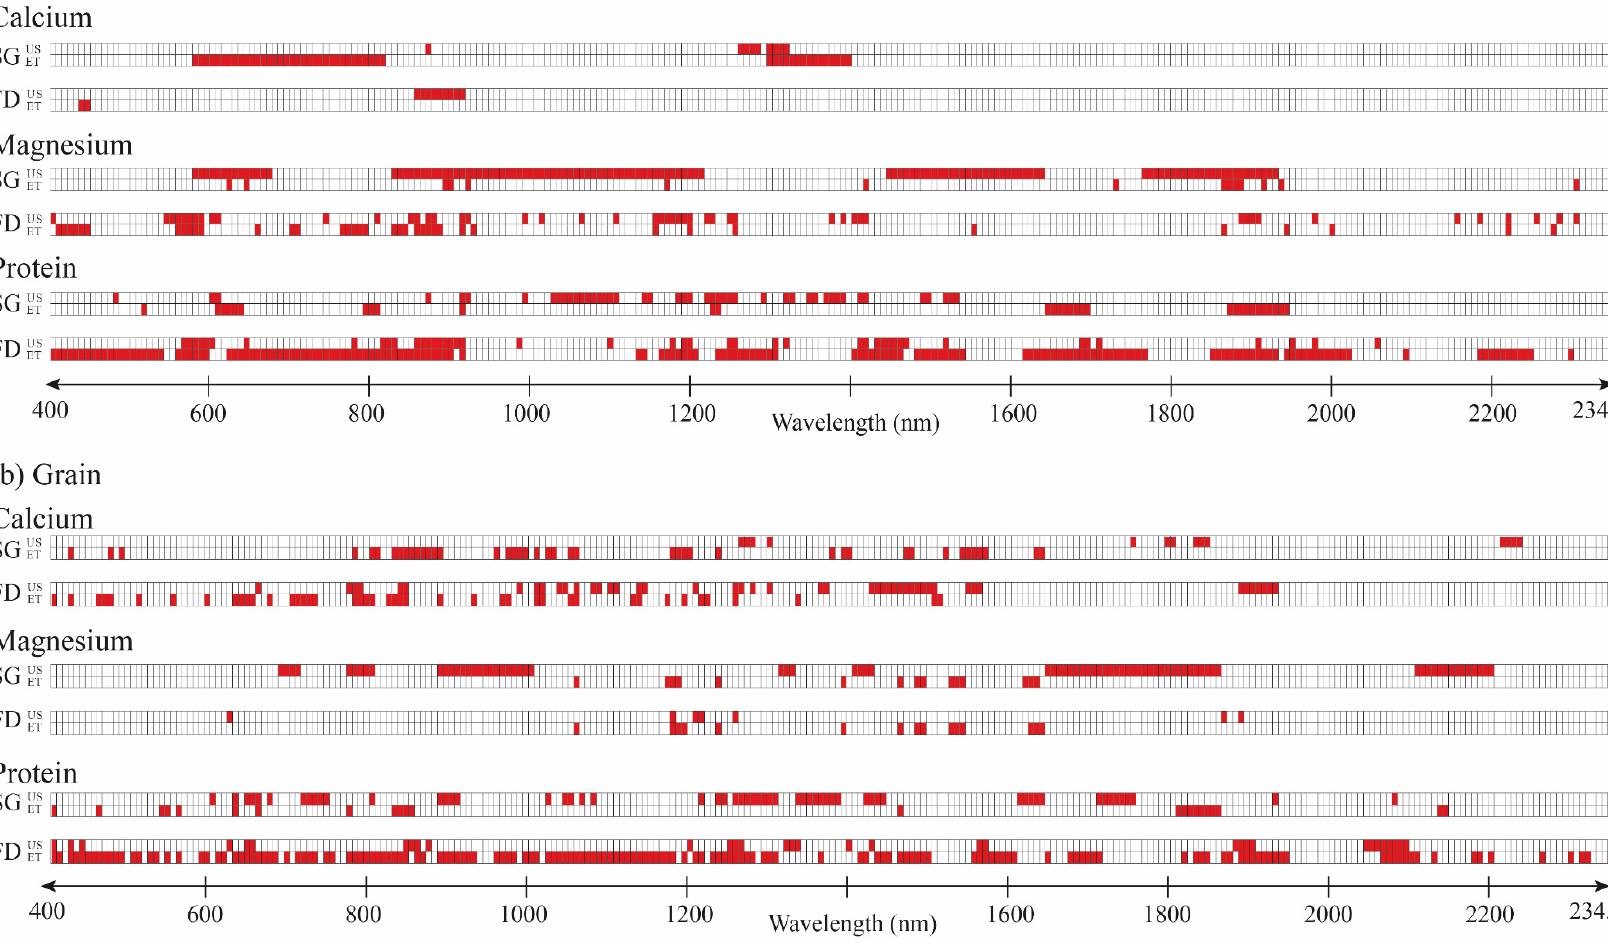
Figure 6. Selected wavebands (red) from the partial least square regression (PLS) using waveband selection for ( a ) plant, and ( b ) grain. Abbreviations: SG: Savitsky– Figure6. Selectedwavebands(red)fromthepartialleastsquareregression(PLS)usingwavebandselectionfor( a )plant, and( b )grain. Abbreviations:SG:Savitsky–Golay; Golay; FD: First derivative; US: United States; ET: Ethiopia. FD: First derivative; US: United States; ET: